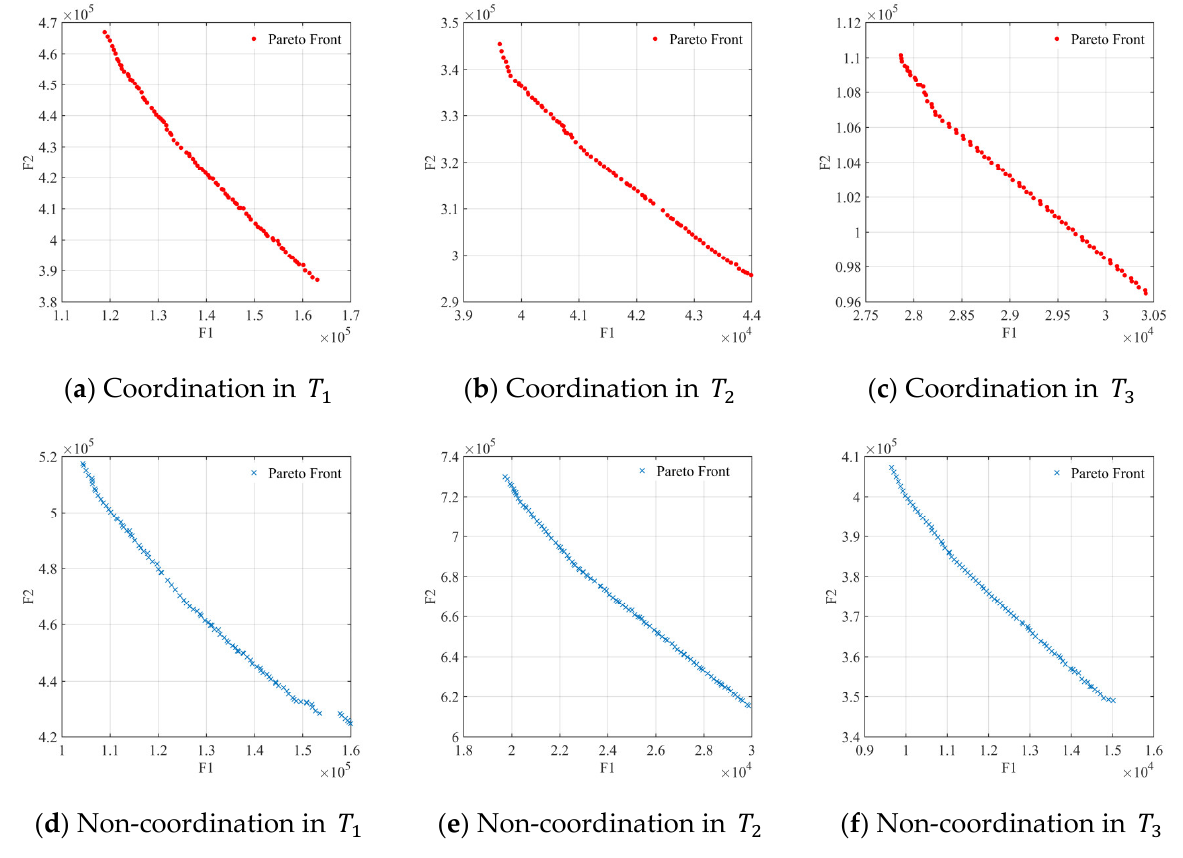
Figure 13. Impact of coordination mechanisms.